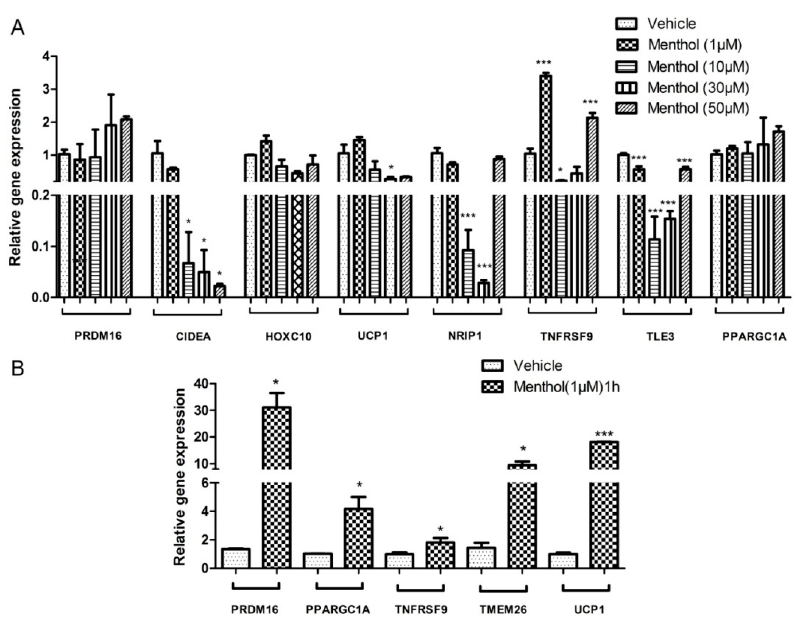
Figure 4. E ff ect of menthol treatment on: ( A ) Relative expression of energy expenditure genes in Figure 4. Effect of menthol treatment on : ( A ) Relative expression of energy expenditure genes in 3T3- 3T3-L1 cells at 1 µ M, 10 µ M, 30 µ M and 50 µ M menthol treatment; ( B )Relative expression of energy L1 cells at 1 µM, 10 µM, 30 µM and 50 µM menthol treatment; ( B )Relative expression of energy expenditure genes in 3T3-L1 cells at 1 µ M menthol treatment for 1 h. n = 3–5; All the values expenditure genes in 3T3-L1 cells at 1 µM menthol treatment for 1hour. n = 3–5; All the values are